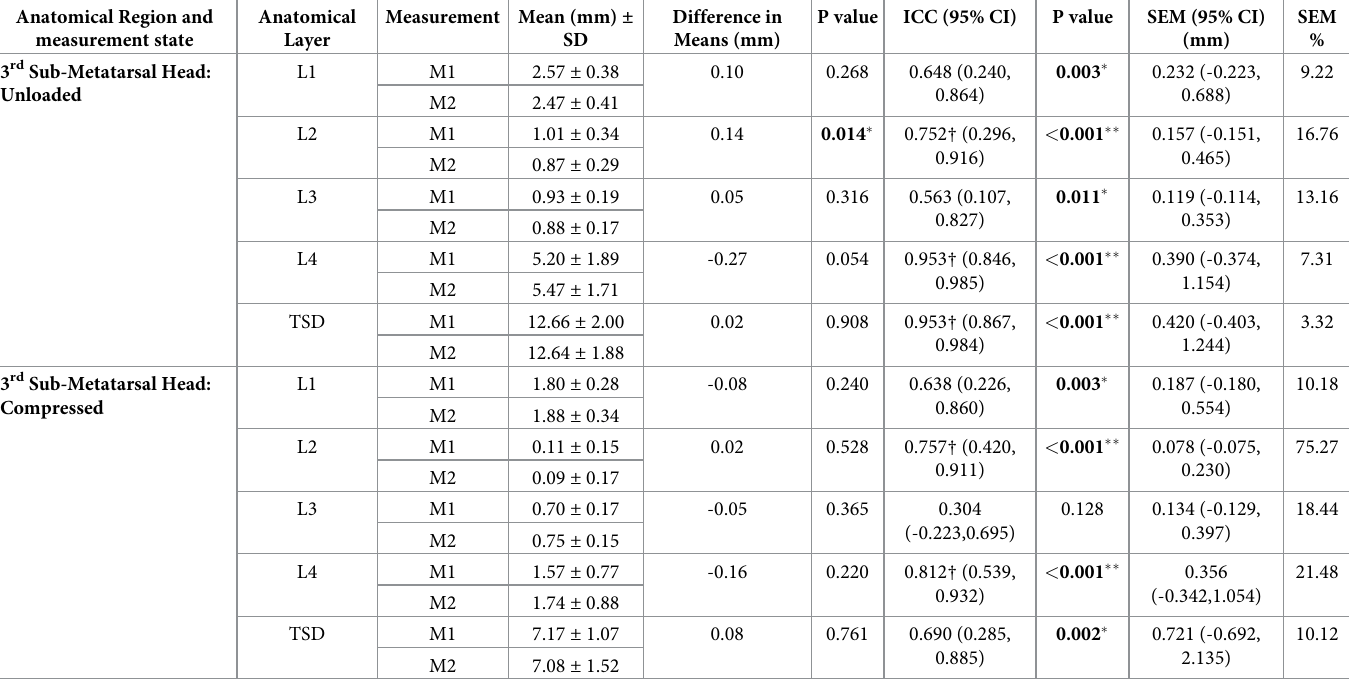
Table 5. Results for intra-observer reliability testing of skin and fat pad thickness at the 3 rd sub-metatarsal head foot region. Anatomical Region and measurement